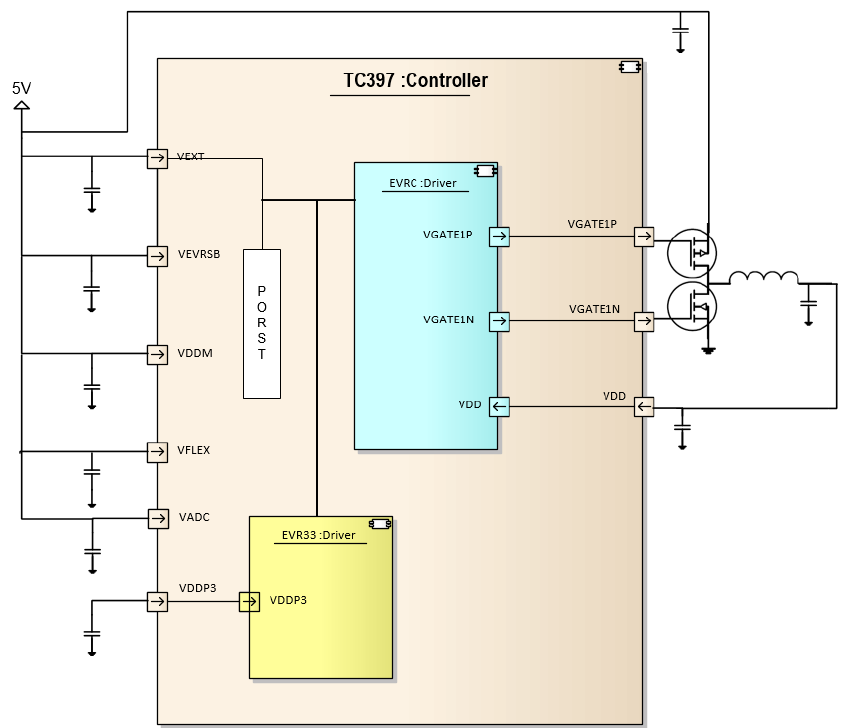
Figure 8. Microcontroller proposed supply overview.